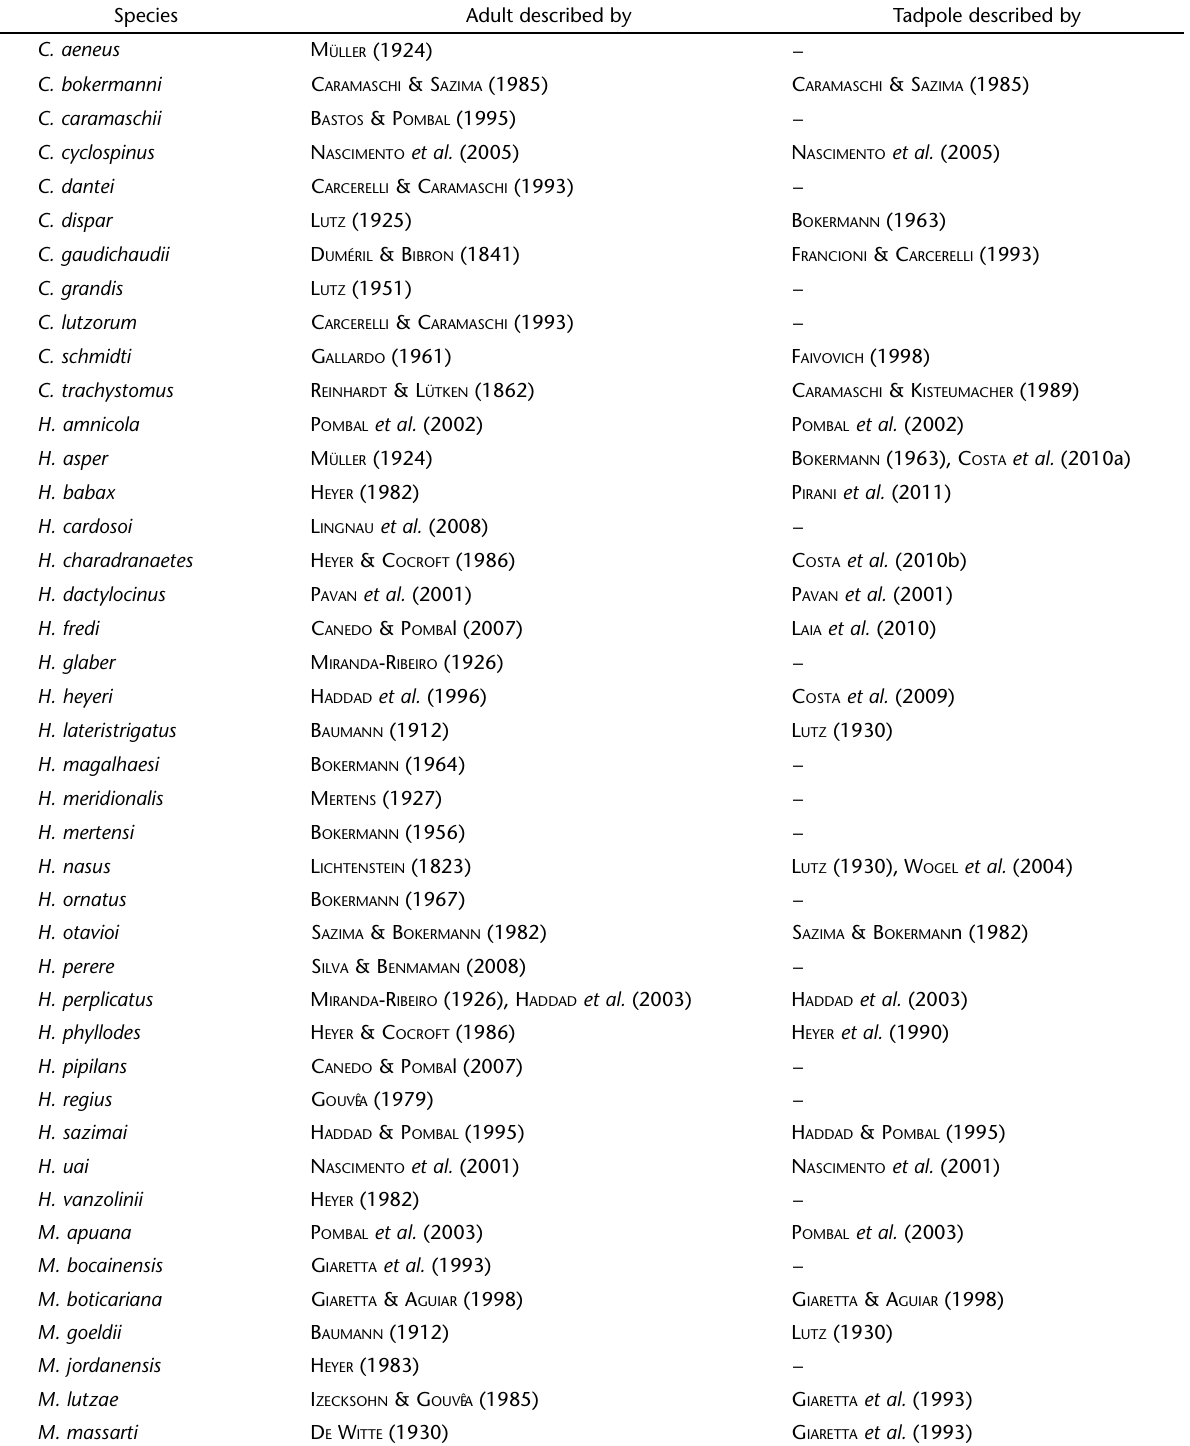
Table I. Species of Hylodidae ( Crossodactylus , Hylodes , and Megaelosia ), and descriptions dates of their adults and tadpoles. Species Adult described by Tadpole described